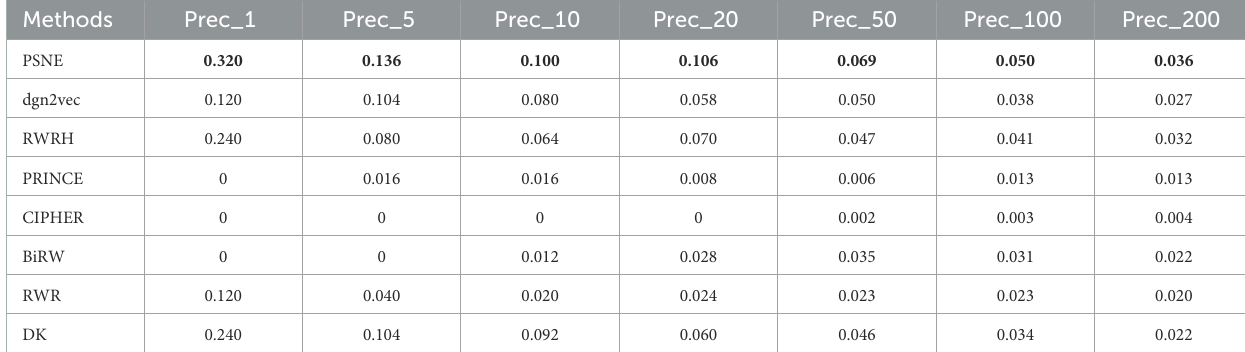
TABLE 3 For Alzheimer’s disease, the performance evaluation of PSNE in terms of top-k Precision (k = 1, 5, 10, 50, 100, and 200), with comparison to the state-of-the-art